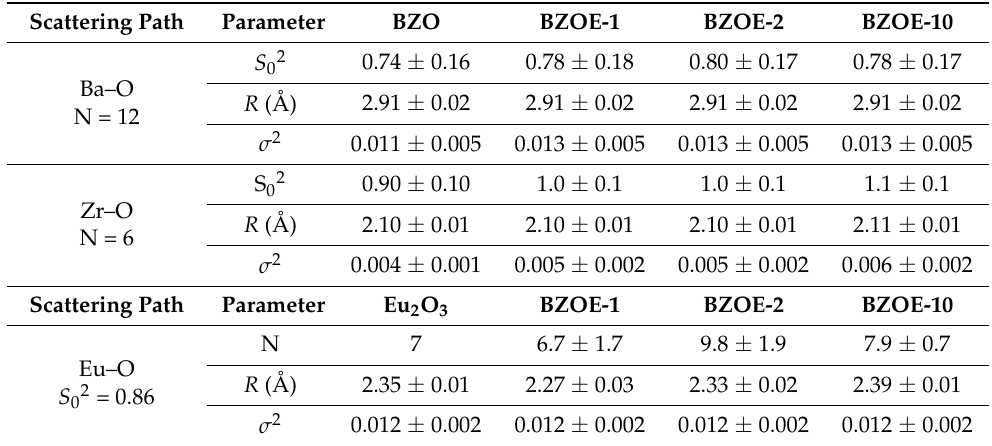
Table 2. Values of the amplitude reduction factor ( S 02 ) or path degeneracy (N), bond length, and disorder factor for the near neighbor paths obtained from EXAFS analysis of the BZO and BZOE samples at the Ba L 3 , Zr K, and Eu L 3